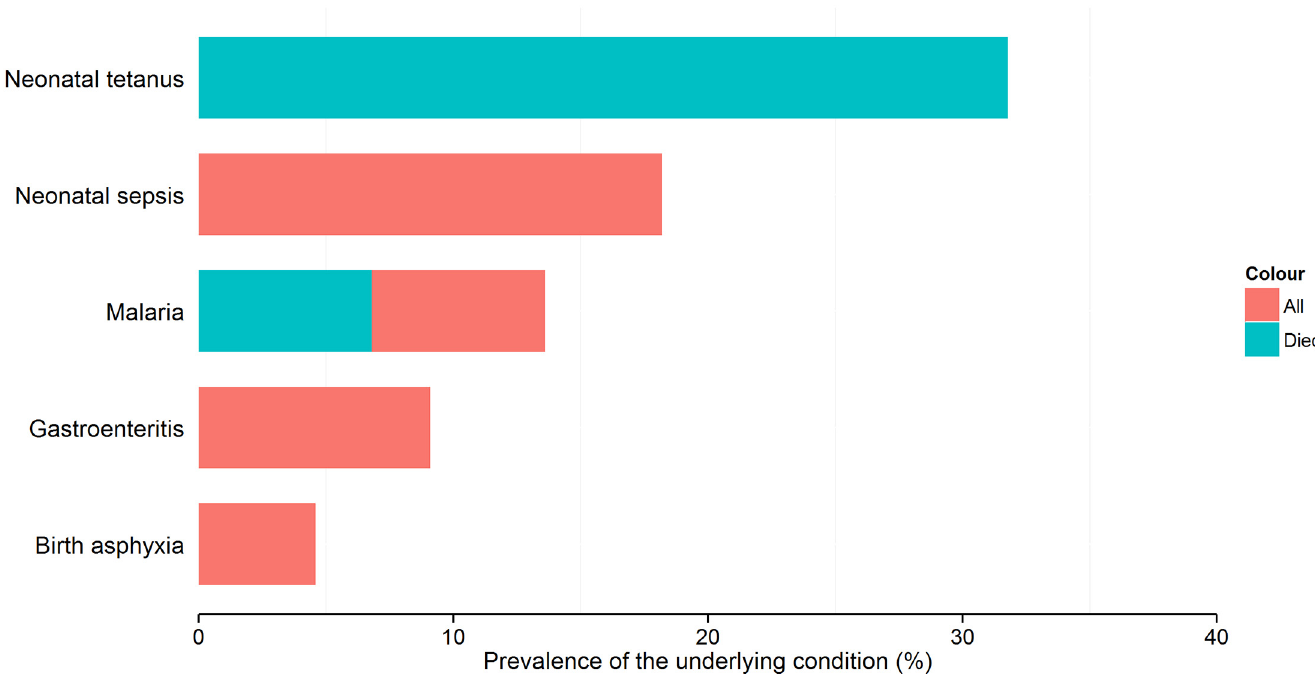
Fig 2. Most common underlying conditions in children with hypernatremia. This figure shows the most common underlying conditions in hypernatremic children. Red shows the percentage of children with the condition while blue represents the percentage that died from that condition. A completely blue bar means that all children with that condition